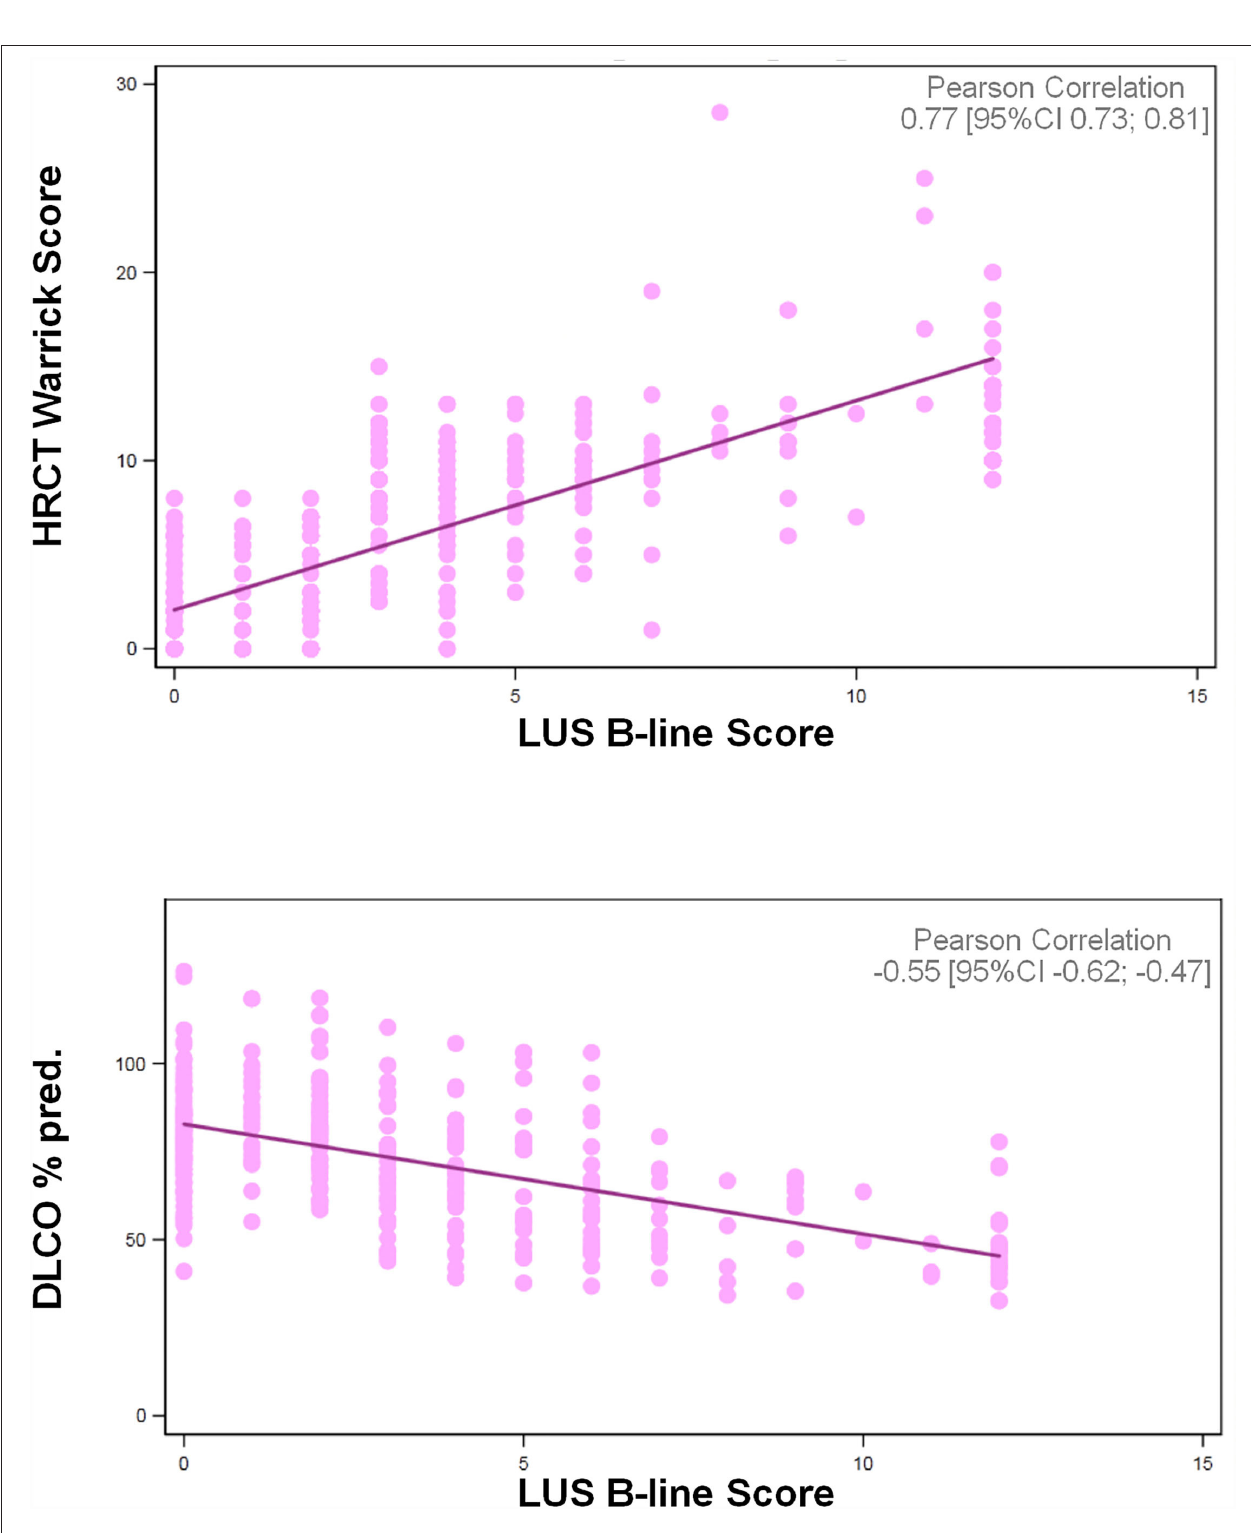
of any other specific score. Moreover, a Warrick cut-off point of ≥ 7 could lead to the underdiagnosis of milder forms of ILD. In our favor, it is likely that minor abnormalities are not